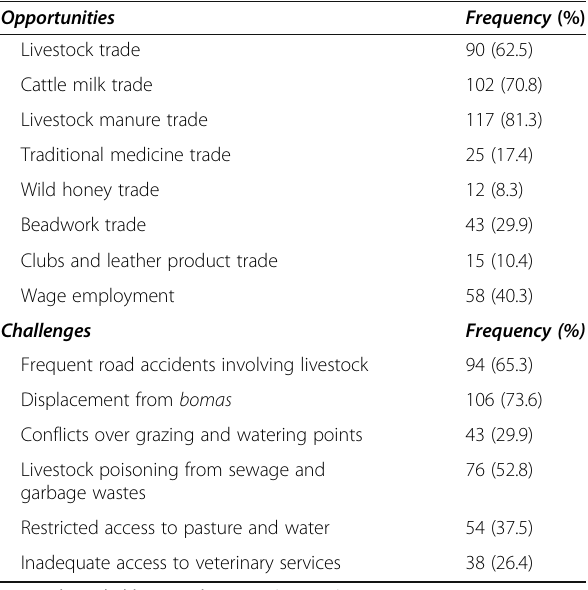
Table 5 Opportunities and challenges encountered in the